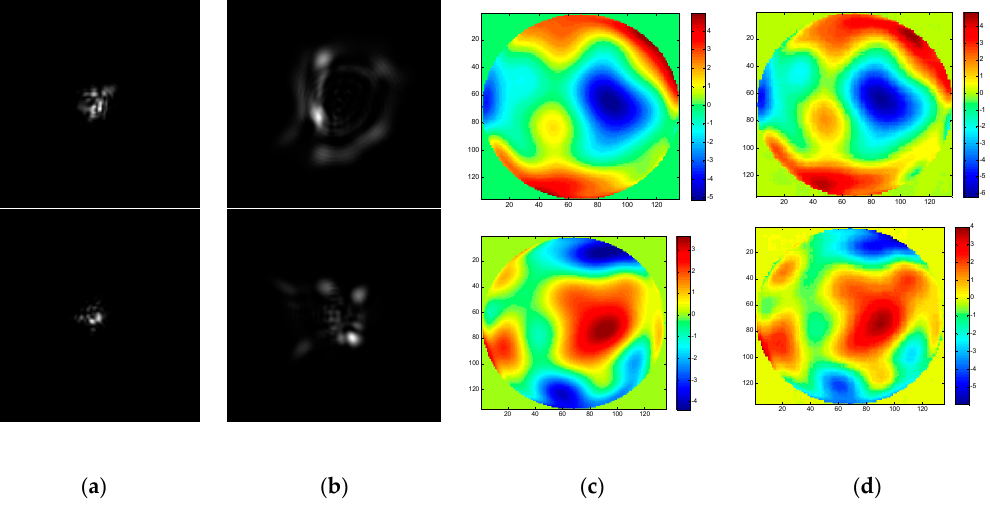
Figure 6. Predicting effect of ( a ) the initial in focus PSF images; ( b ) the initial defocus PSF images; ( c ) the initial wavefront maps; ( d ) the wavefront maps by the De-VGG predicted for D/r 0 = 6. To verify the fitting e ff ect of the model, in addition to RMS, we introduce the normalized-pixel-mean-square (NPMS). It is the normalized mean square of pixels between the output phase maps of the De-VGG and the corresponding input PSF images. NPMS of 2000 test sets was taken as the model evaluation index. As shown in Table 1, the NPMS is 0.0067 and the RMS is 0.1307 λ with D/r 0 = 20, which has a better accuracy than existing neural networks. When the D/r 0 = 15, the NPMS is 0.0041 and the RMS is 0.0909 λ . The RMS is 0.0718 λ with D/r 0 = 10, proving that the De-VGG can fit the phase map generated by atmospheric turbulence perfectly. The result is consistent with the actual situation and it certificates the applicability of the De-VGG